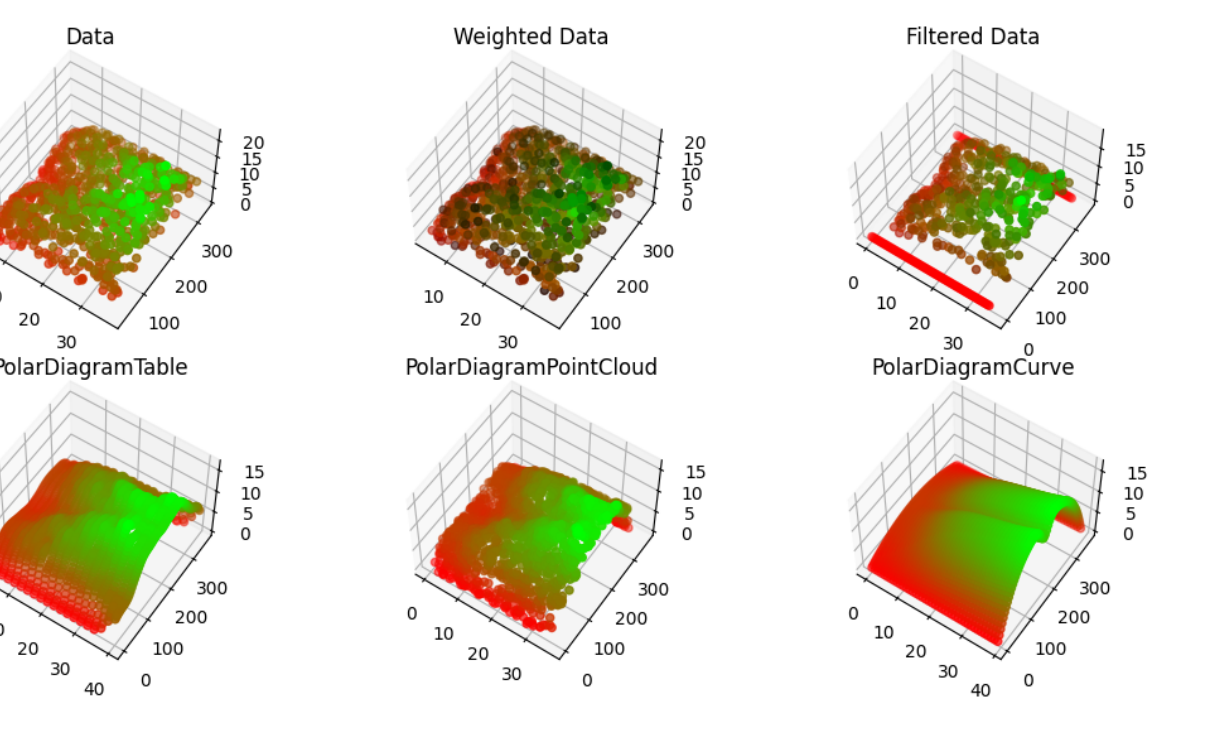
Figure 10. A visualisation of the interim results of the pipeline. Points with smaller weights are displayed with more shade (if weights are